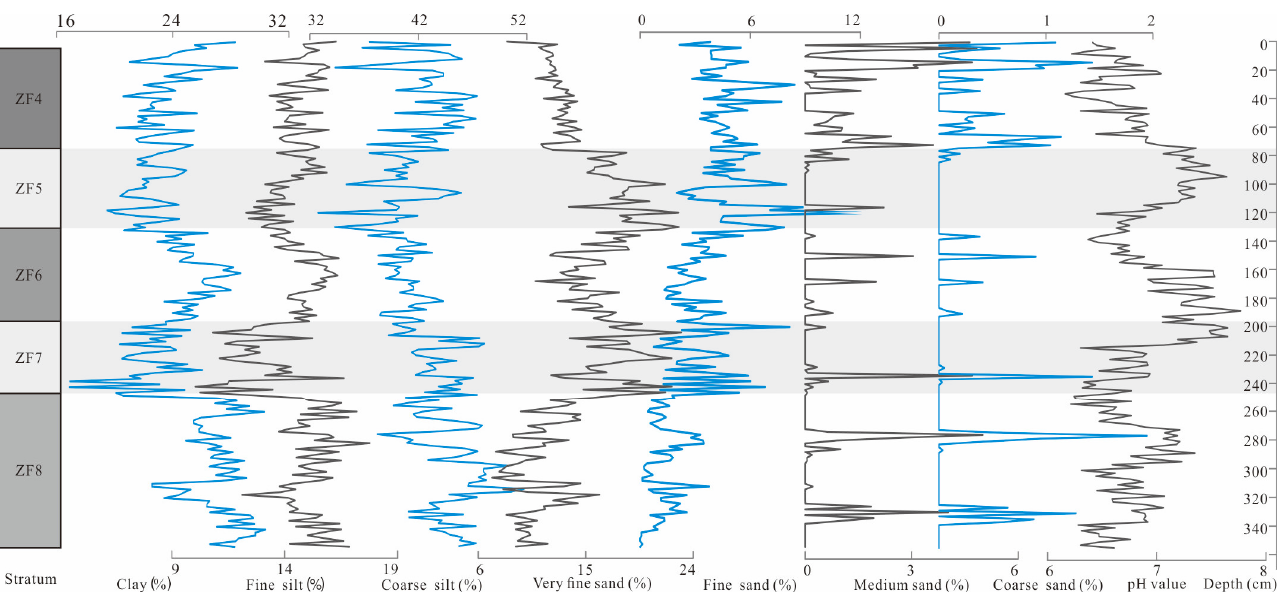
Figure 2. Stratigraphic sequence and age ‒ depth relationship of the ZFS during MIS 5 period.